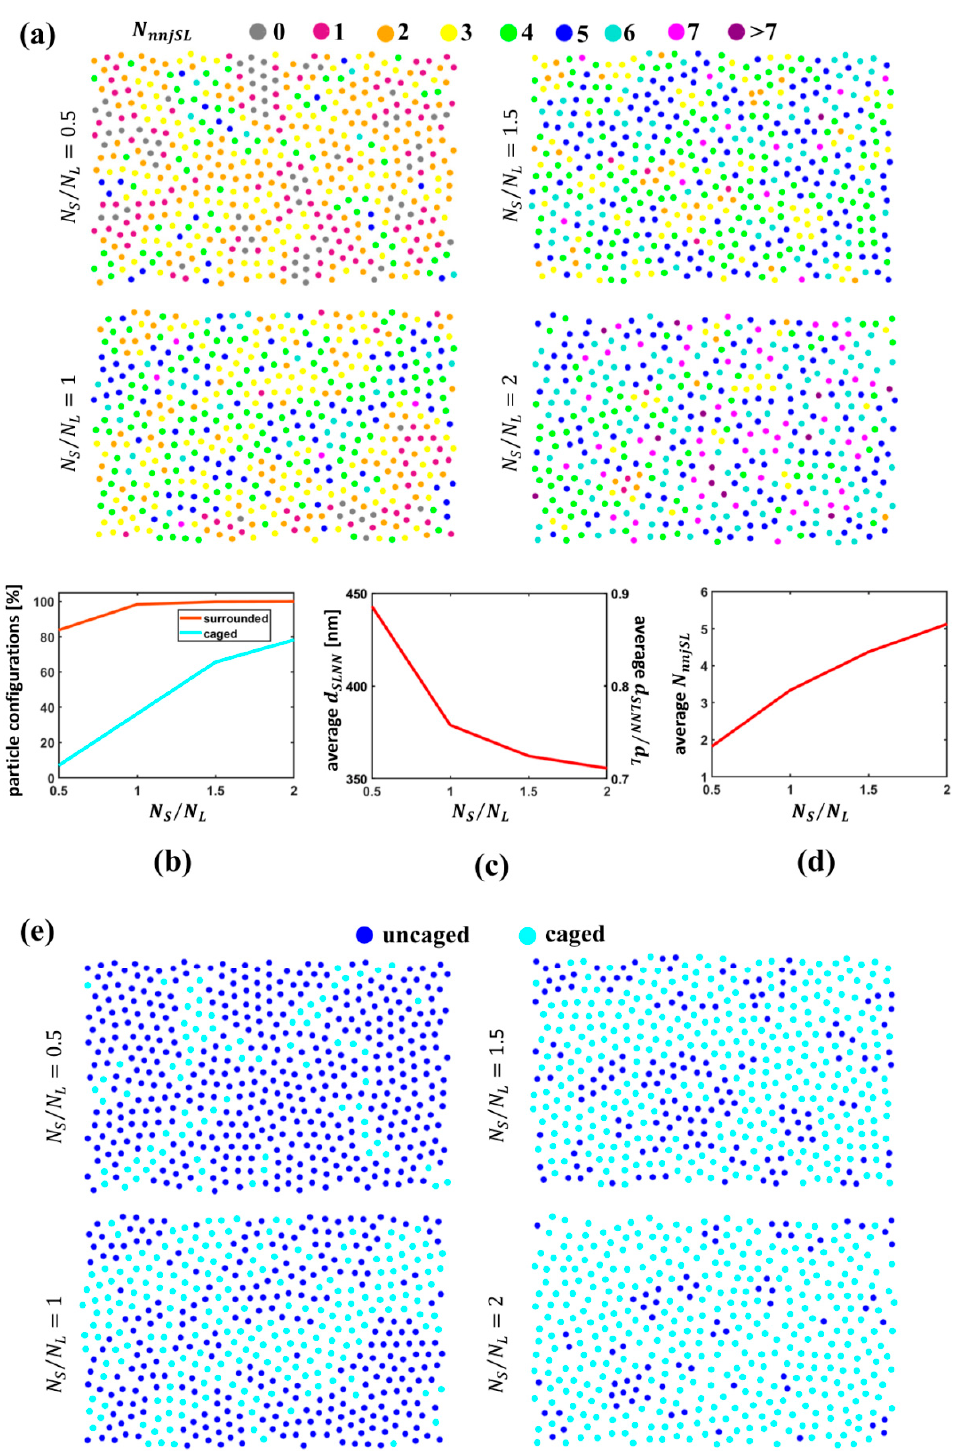
Figure 7. Characterization of S particles with respect to L particles: ( a ) Color-coded representation of L particles according to the number of S nearest neighbors N nnjSL for variable particle number ratio N S /N L ; ( b ) percentage of L particles surrounded by at least one S particle (N nnjSL ≥ 1) and of caged L particles for variable particle number ratio N S /N L ; ( c ) average distance of S nearest neighbors to an L particle from the L particle d SLNN ; ( d ) average number of S nearest neighbors N nnjSL for variable particle number ratio N S /N L ; ( e ) color-coded representation of caged and uncaged L particles for variable particle number ratio N S /N L